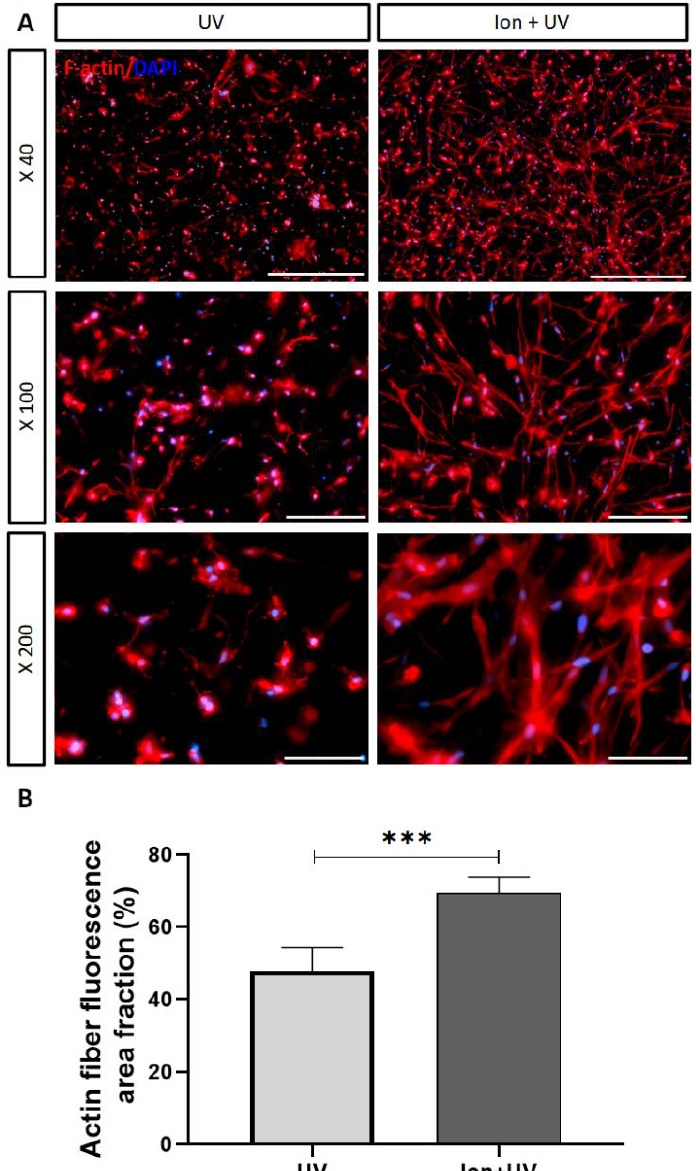
Figure 6. Fluorescence micrograph of phalloidin/DAPI staining assay. ( A ) Cells were stained with phalloidin (red) and DAPI (blue) at 72 h (scale bar = 40×, 500 μm; 100×, 200 μm; 200×, 100 μm). ( B ) Percent of actin fiber fluorescence area fraction ( n = 5) (data were expressed as mean ± S.D. *** p < 0.001).